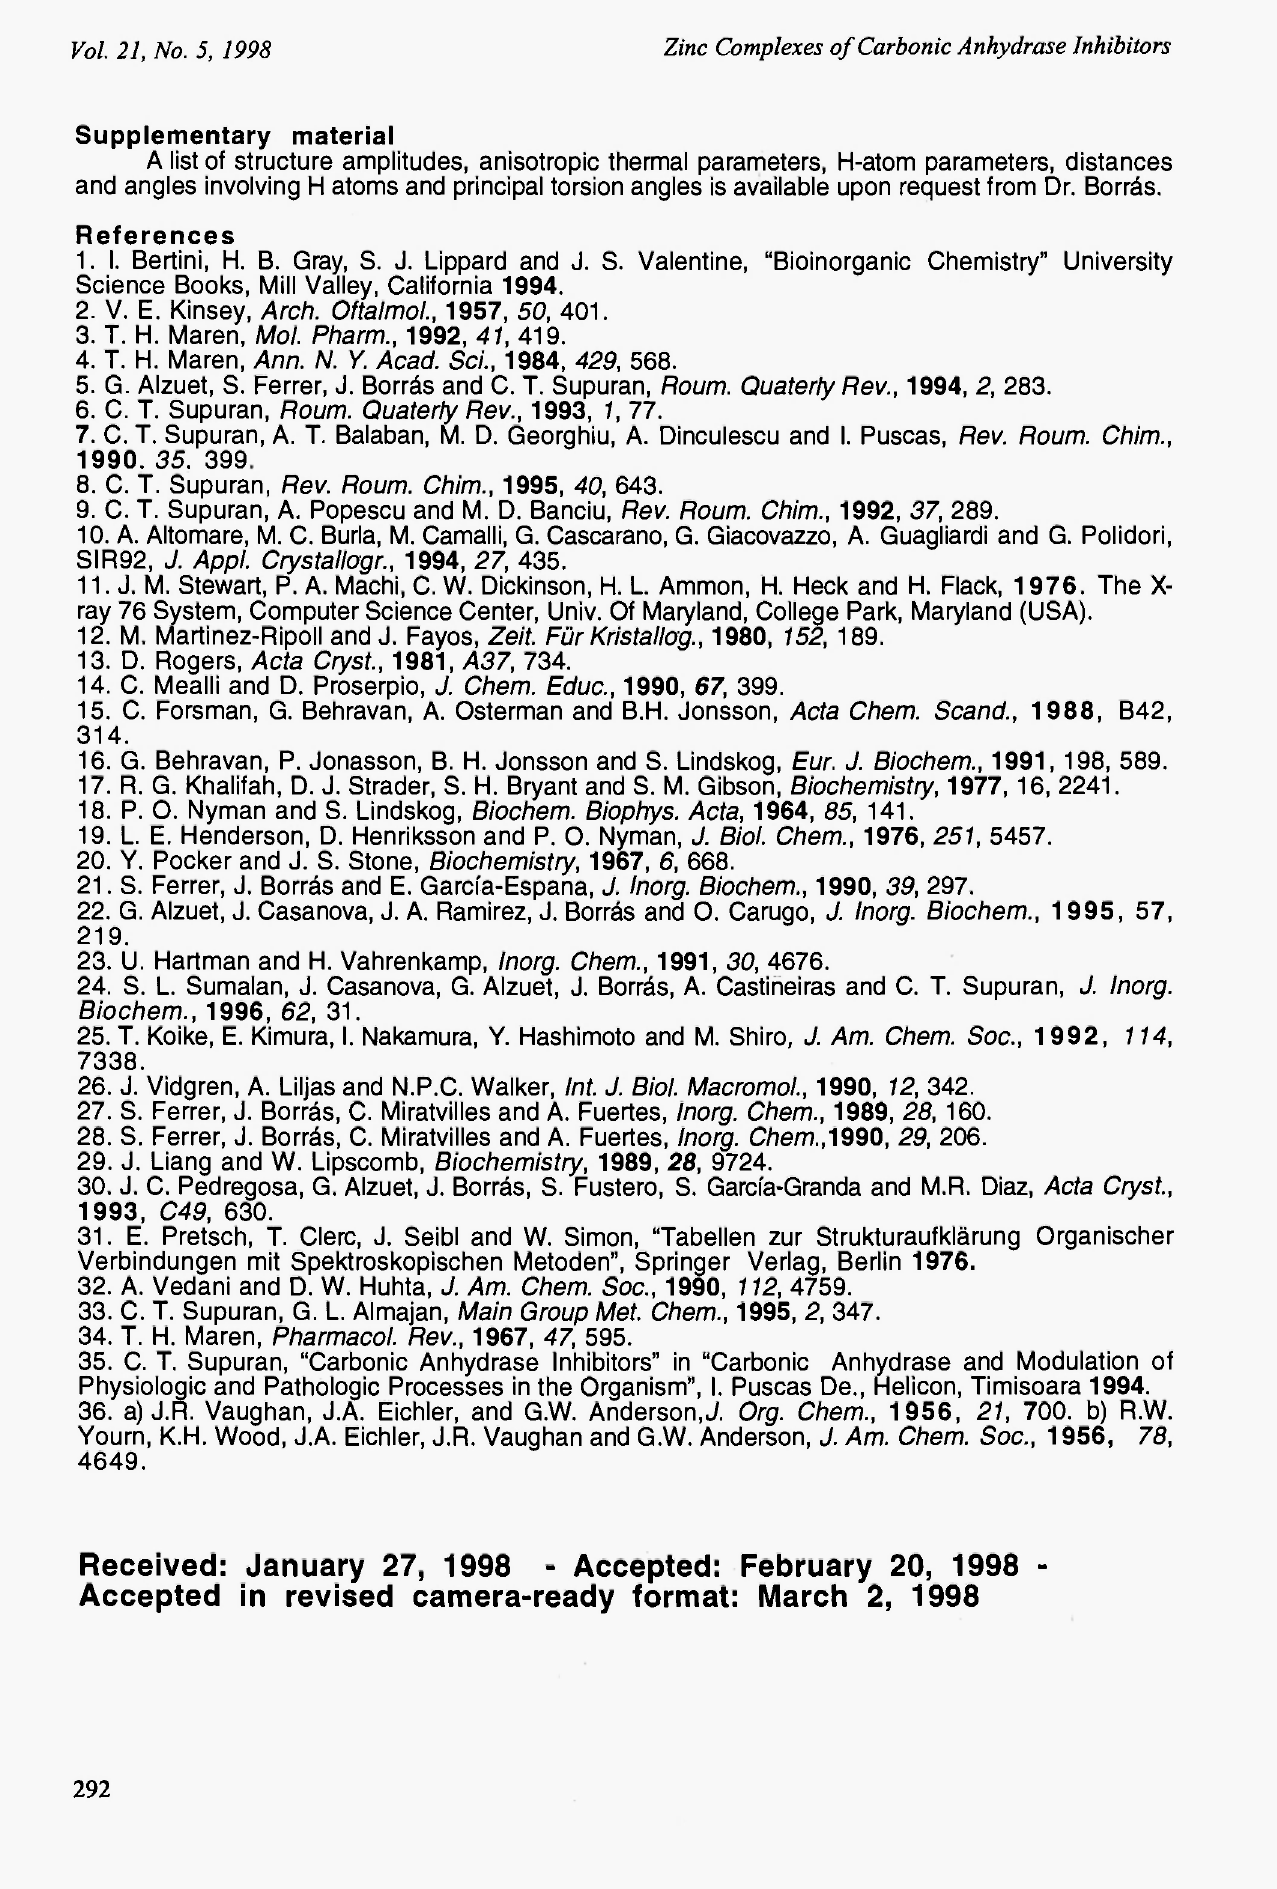
A list of structure amplitudes, anisotropic thermal parameters, Η-atom parameters, distances and angles involving Η atoms and principal torsion angles is available upon request from Dr.